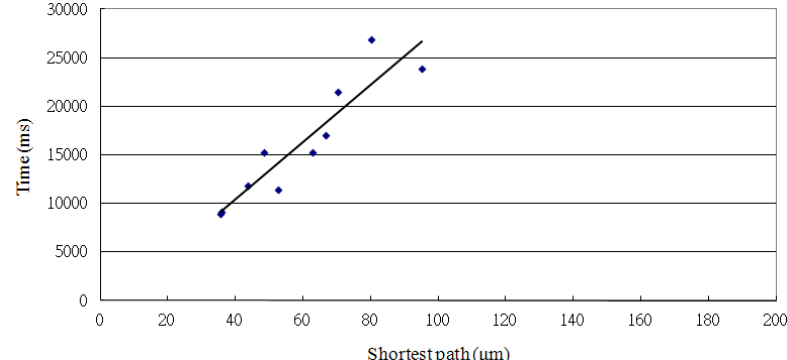
Figure 14. Relationship between the positioning time and the shortest path with time as the control factor.